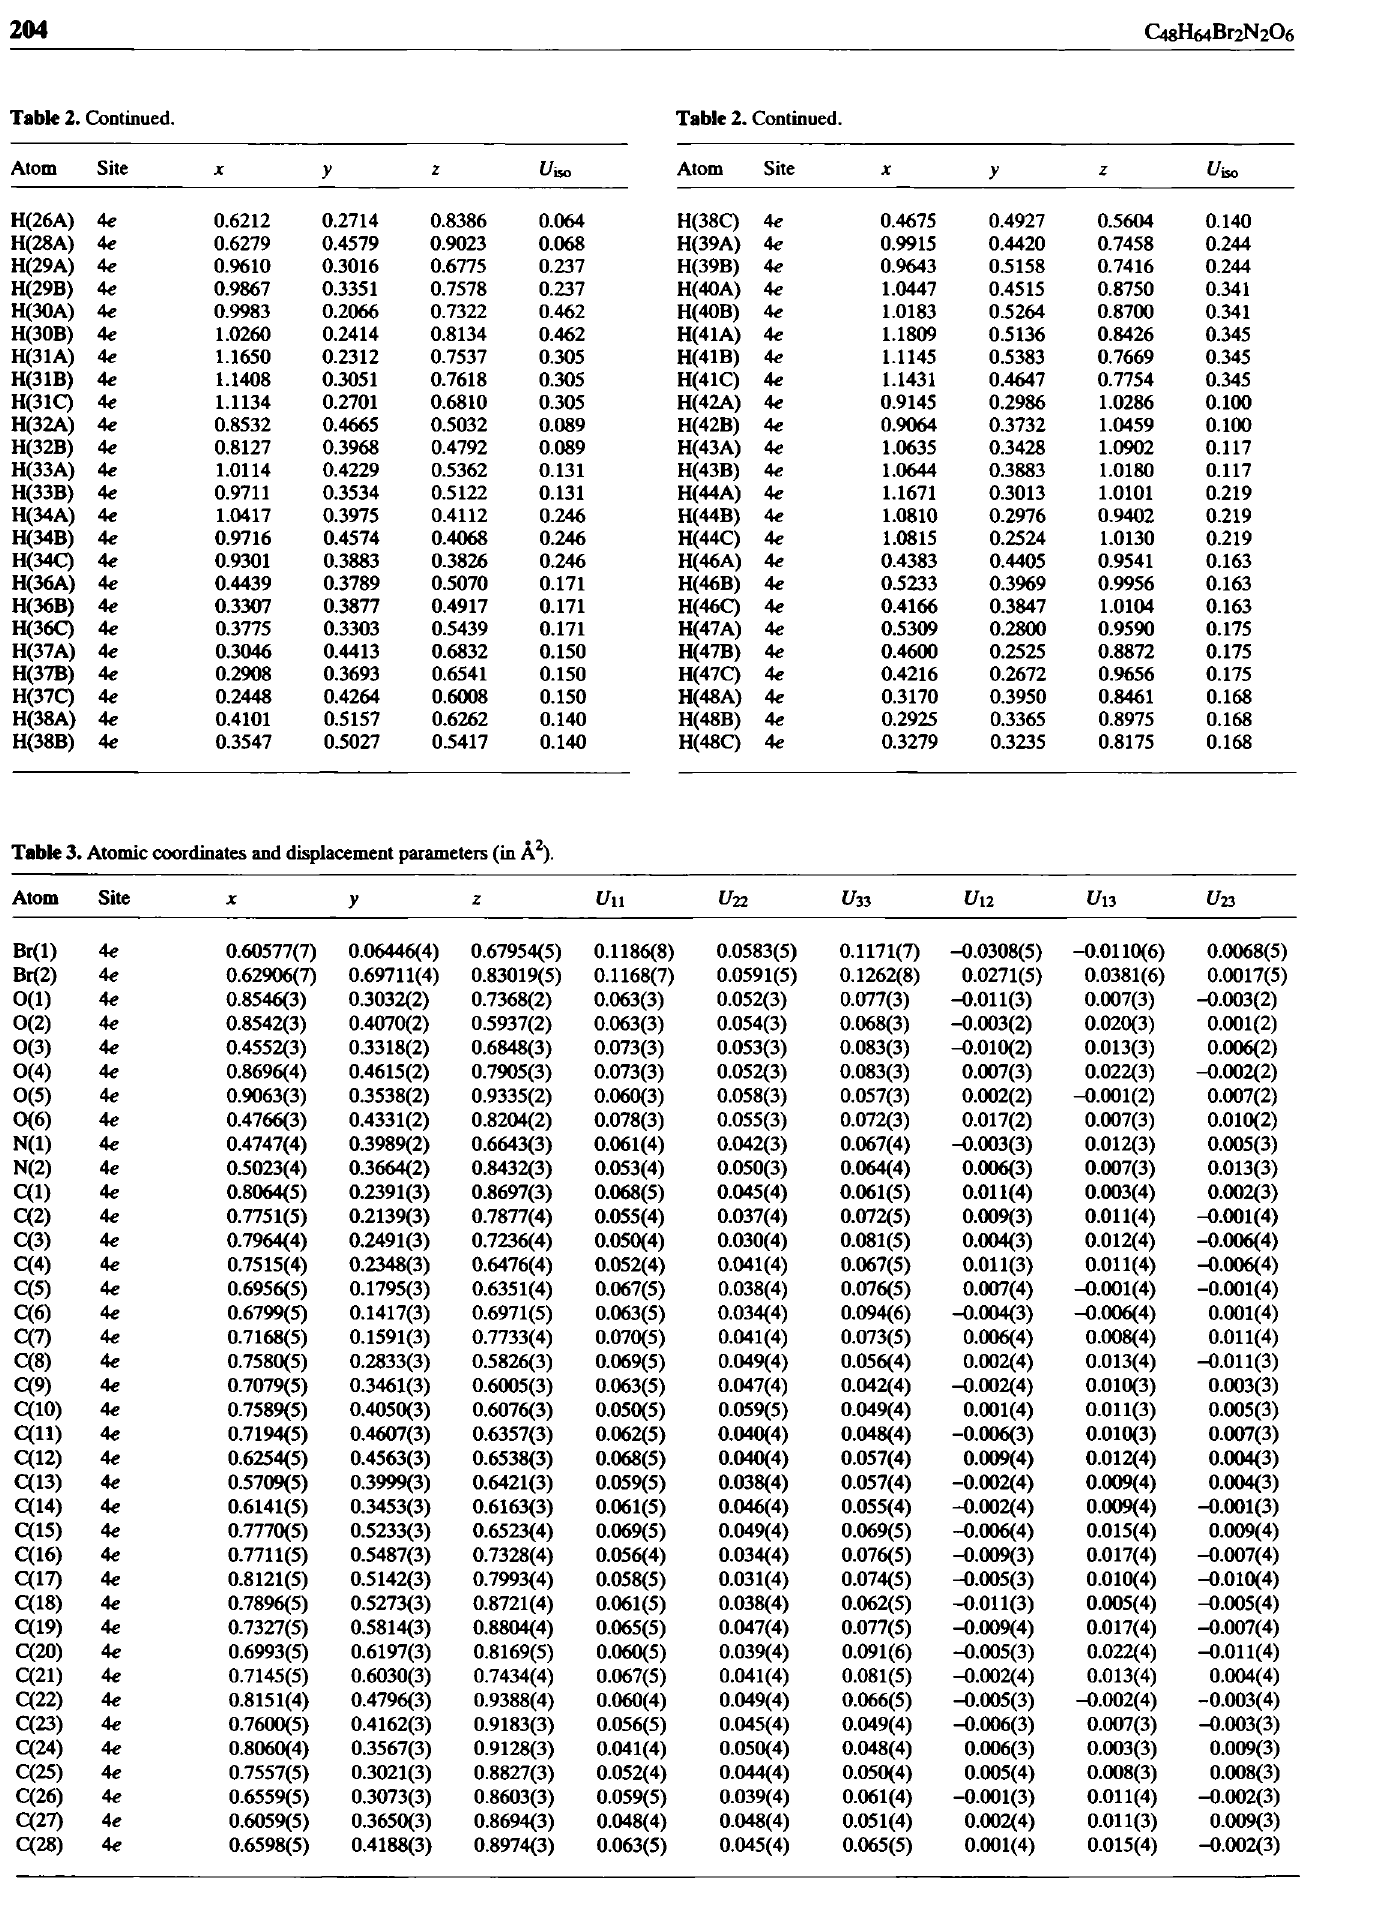
Table 3. Atomic coordinates and displacement parameters (in Ä 2